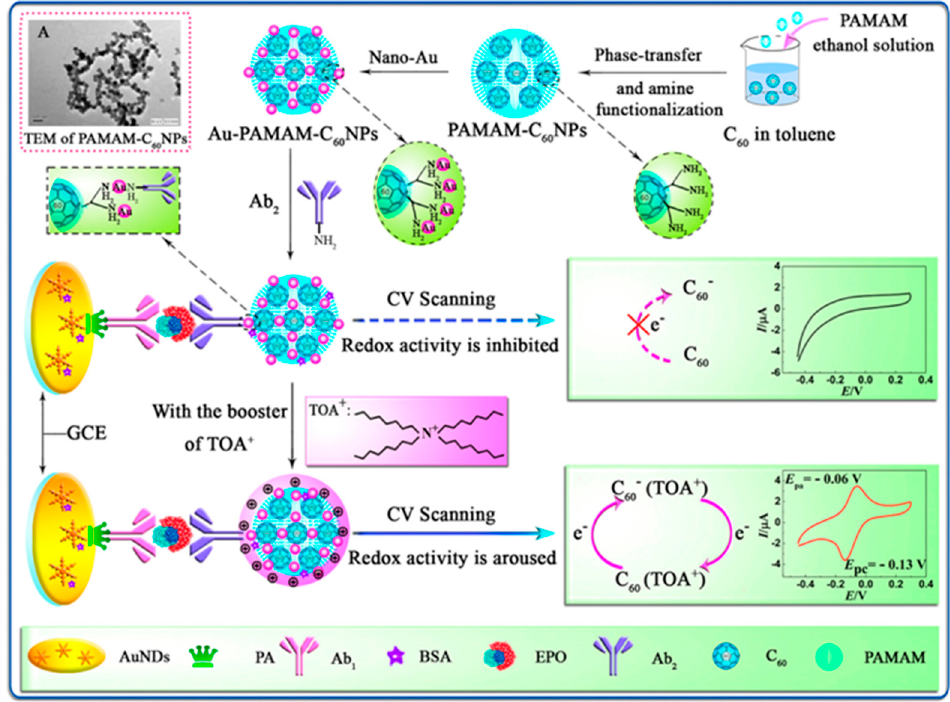
Figure 10. Schematic illustration of the immunosensor preparation process using bioconjugates of detector antibodies (Ab 2 ) and (Au/PAMAM/C60)NPs as advanced labels and mechanism of electrochemical reaction. See the text for more information. Reprinted from [81] with permission.